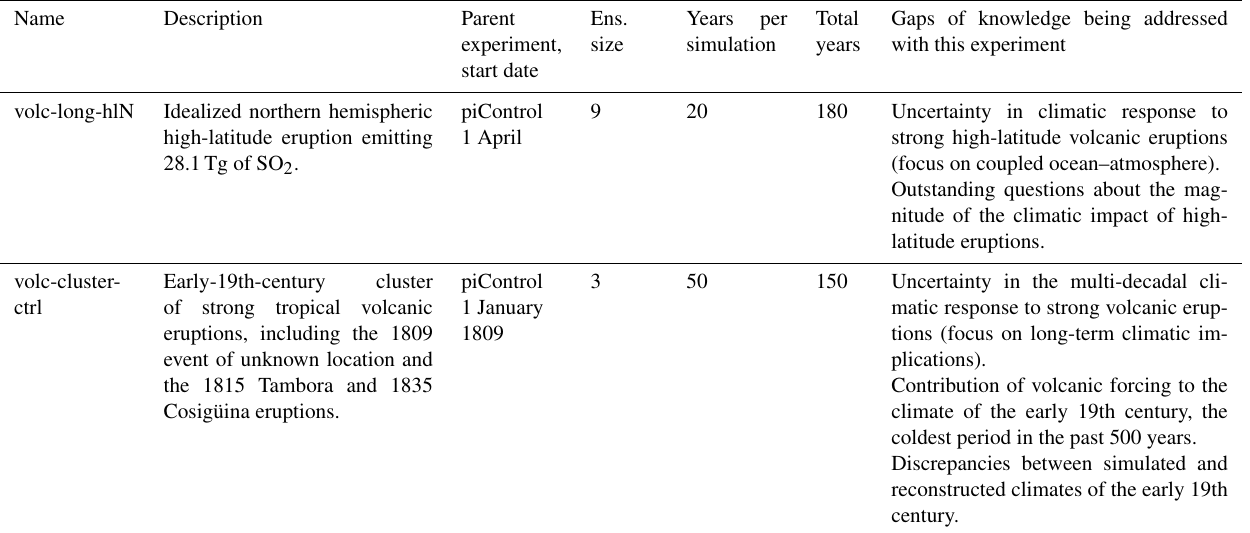
Table 2. Tier 2 VolMIP